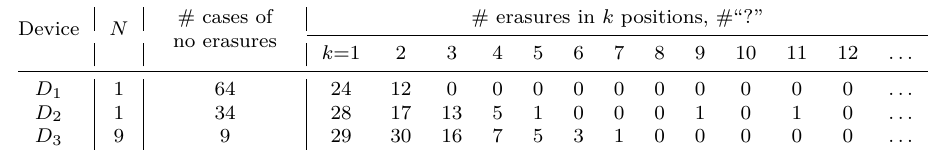
Table 11: Empirical distribution of erasures in the ECC-based key recovery attack based on [8 , 4 , 4] 2 extended Hamming code (100